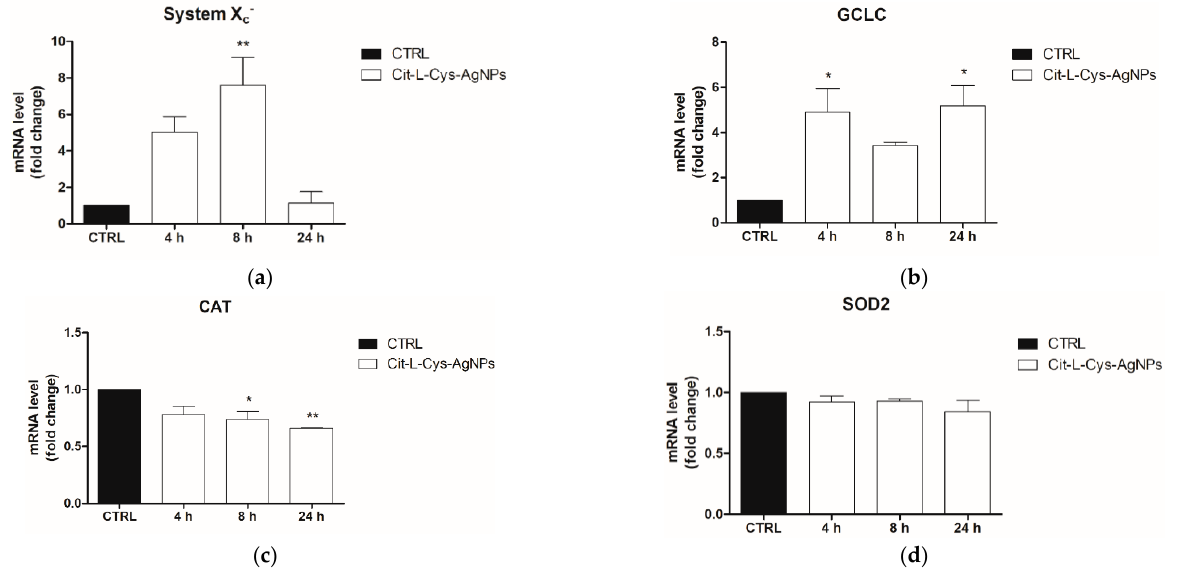
Figure 12. Evaluation of ARE gene expression (mRNA levels) following treatment of HEK293T with AgNPs/L-cys/citr (100mM) by RT-qPCR. Gene analyzed are: ( a ) xCT; ( b ) GCLC; ( c ) SOD2; ( d ) CAT. * p < 0.05 vs. CTRL; ** p < 0.01 vs.